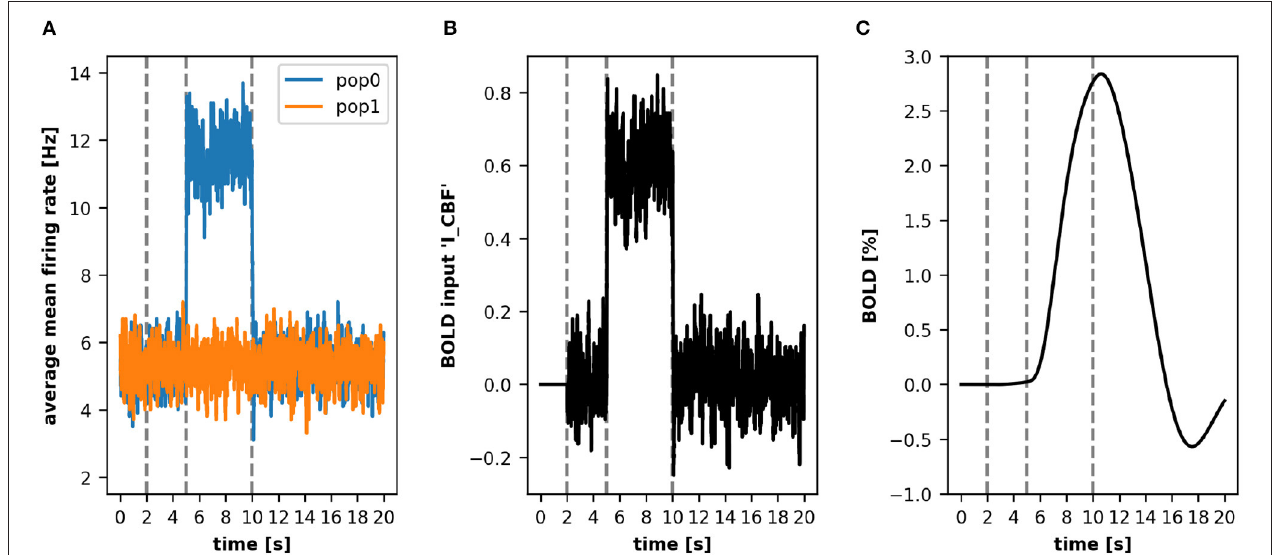
FIGURE 3 | A simple simulation using the ANNarchy BOLD monitor. In this example, we obtain a BOLD signal from two populations pop0 and pop1 . Both populations contribute their mean-firing rate r (A) to the BOLD model which we defined in Section 3.4. After 5 s of simulation, the noise variable in pop0 is increased which leads to a higher mean-firing rate. This increases the input signal I_CBF (B) and consequently the computed BOLD signal (C) . For clarity, the vertical lines depict three relevant time points (left to right): end of baseline period, time point of increased noise variable, time point of reset noise